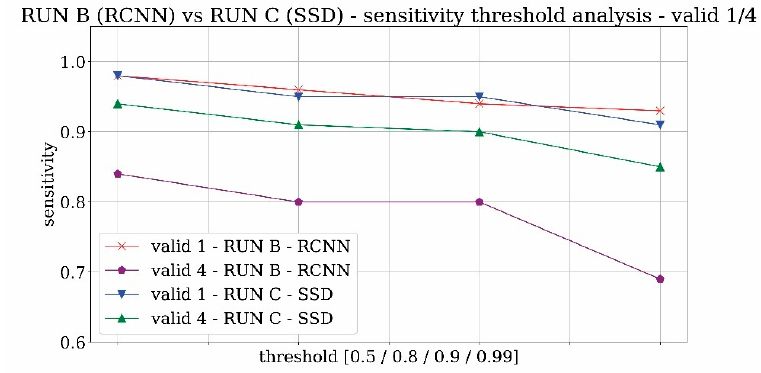
Figure 13. Specificity threshold analysis for RUN A and RUN B with valid 2 and 3.